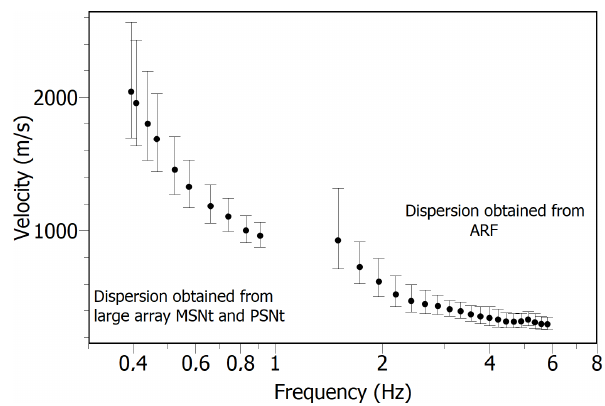
Figure 7. Observed phase velocity obtained averaging the disper- sion values estimated from the f – k analysis applied to PSNt and MSNt arrays (Fig. 6), and the f – k and MSPAC analysis plus the single phase velocity values derived from the analysis of coherent transient signals, for the array ARF (Fig. 5). Table 2. The velocity profile with the lower misfit value (0.515).